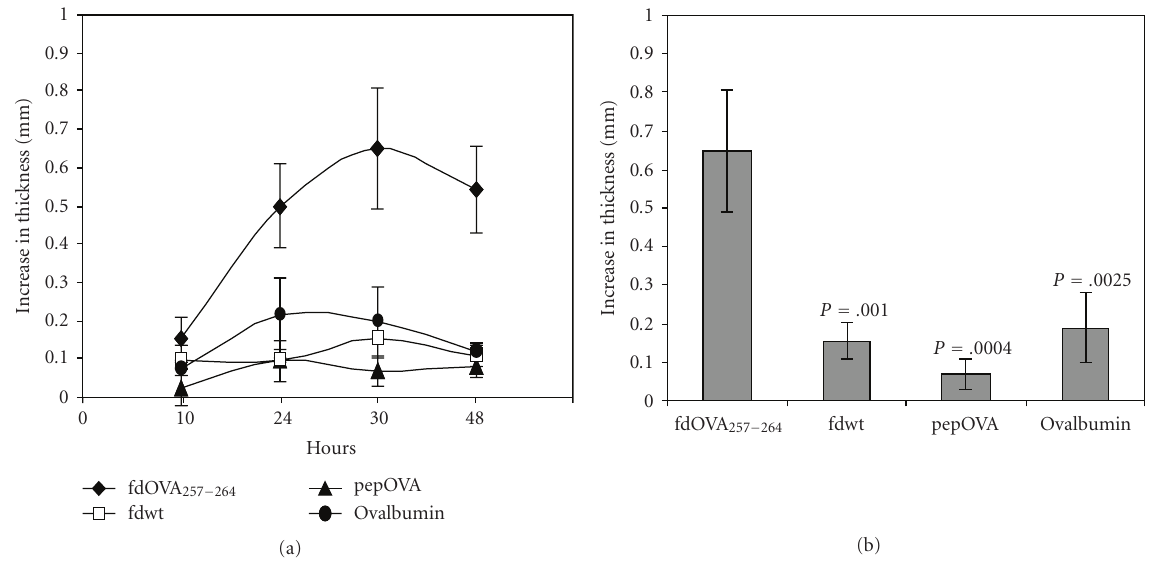
Figure 1: fdOVA 257–264 administration is able to trigger DTH. Mice were sensitized by one injection of 50 μ g of cytotoxic OVA 257–264 (SIINFEKL) peptide and 140 μ g T helper HBVc 128–140 (TPPAYRPPNAPIL) peptide from hepatitis B virus core antigen, emulsified with incomplete Freund’s adjuvant. Ten days after sensitization, DTH was performed by injecting into the right footpad fdOVA 257–264 , fdwt, the synthetic OVA 257–264 peptide (pepOVA), or soluble ovalbumin. 10–48 hours later the area of swelling was measured using a caliper. (a) Curve response of all mice analyzed. (b) Values at 30 hours of mean thickness ± SD of the di ff erent mice groups challenged with the antigens indicated in the abscissa. The P -values were calculated by comparing each group with the fdOVA 257–264 challenged group.